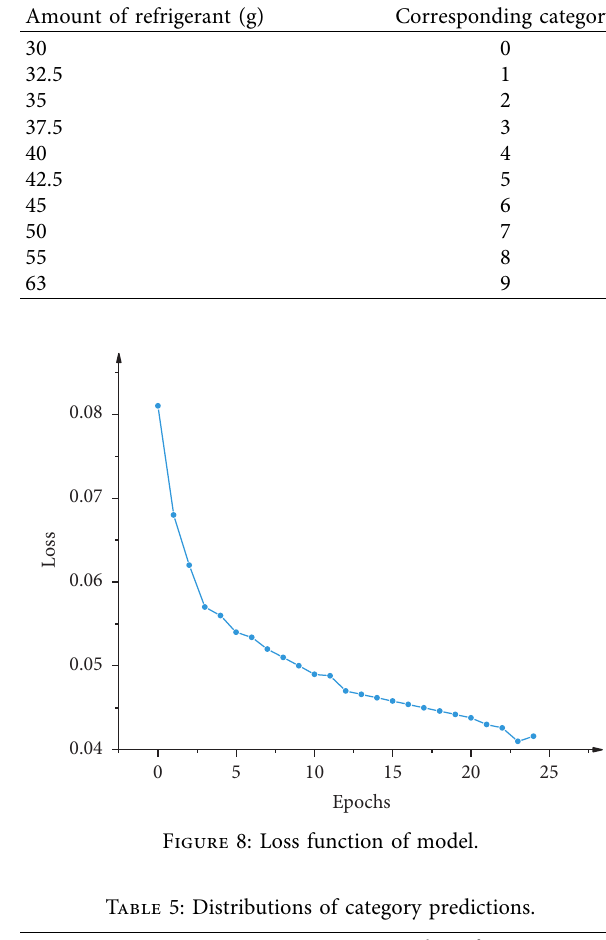
Table 4: Categories corresponding to refrigerant amounts.